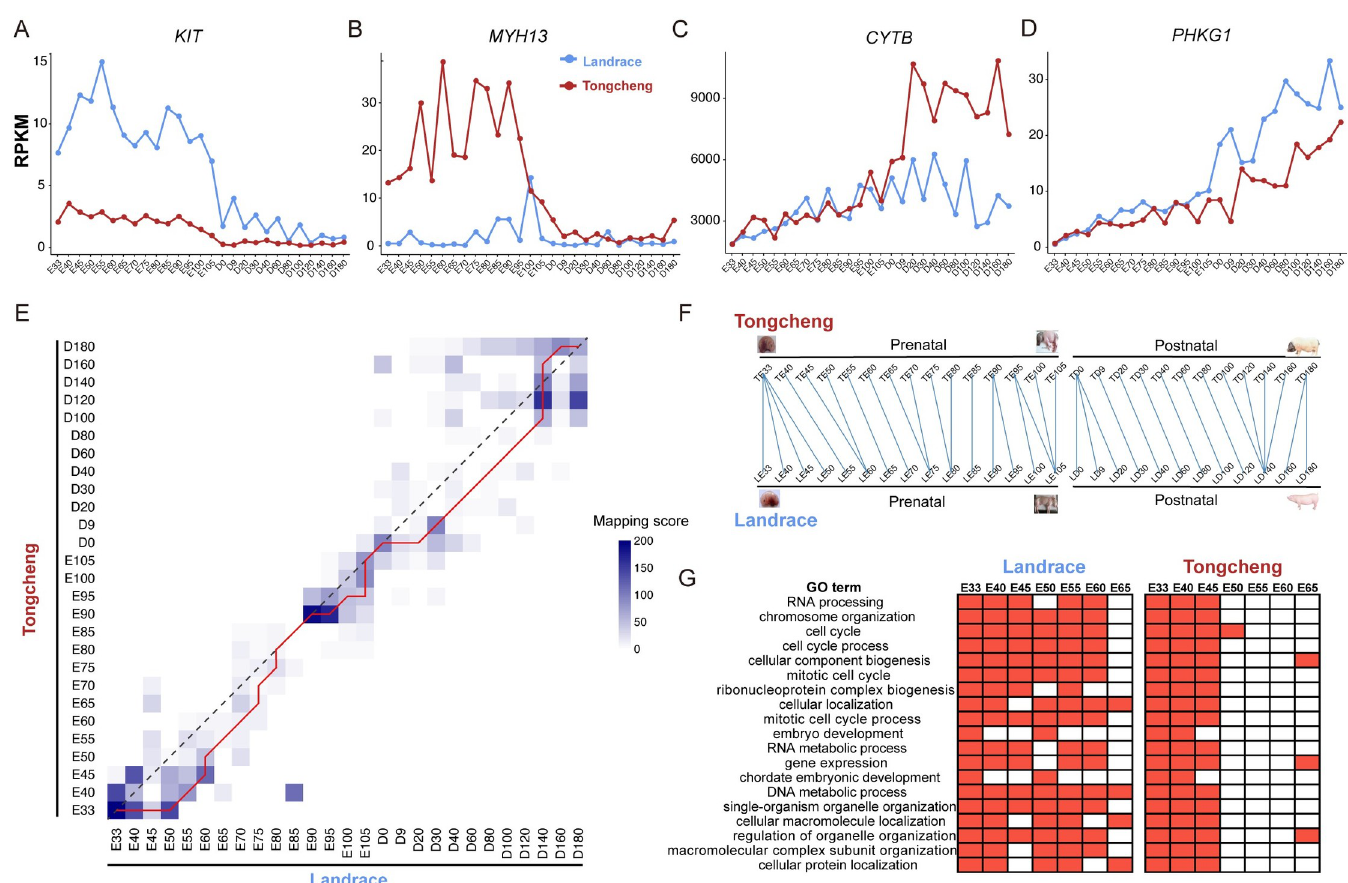
Fig 4. Comparison analysis between Landrace and Tongcheng pigs during skeletal muscle development. ( A-D ) The expression of representative differentially expressed genes ( KIT ( A ), MYH13 ( B ), CYTB ( C ), and PHKG1 ( D )) between Landrace and Tongcheng pigs during skeletal muscle development. ( E ) Comparison of transcriptome similarities across skeletal muscle development between Tongcheng and Landrace pigs. Mapping scores shown in the heatmap are–log10 Bonferroni- corrected P -values, calculated using the hypergeometric test. The red stair-step line was found by maximizing the sum of the mapping scores of the time point pairs it passes through to emphasize the two parallel collinear mapping patterns observed in Landrace and Tongcheng pigs at 27 developmental time points. ( F ) Summary of transcriptome comparisons between Tongcheng and Landrace pigs. ( G ) Comparison of GO enrichment analysis for development-associated genes (DAGs) during the embryonic period. A red block indicates that the GO term at this time point is significantly enriched ( P < 0.05), a white block indicates no significance ( P > 0.05).